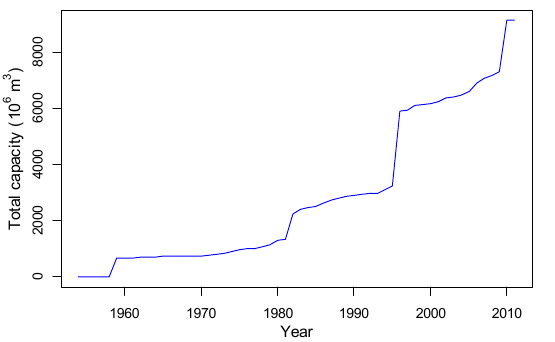
Figure 16. The change of total reservoir capacity in the Min River basin during 1954–2011.